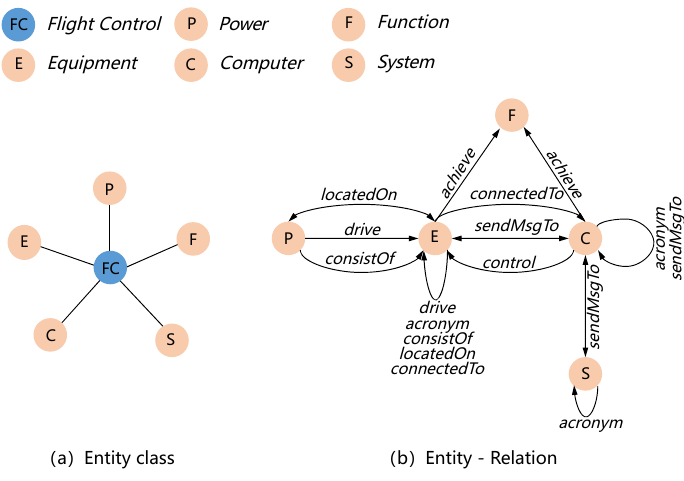
Figure 3. Overview of